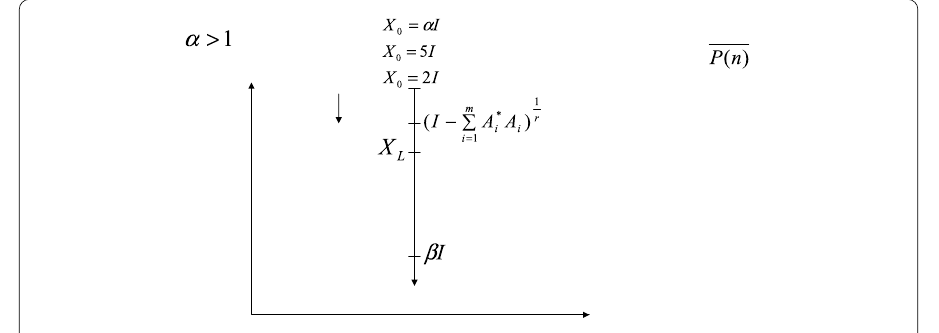
Figure 1 The effect of increasing α on the number of iterations of Algorithm